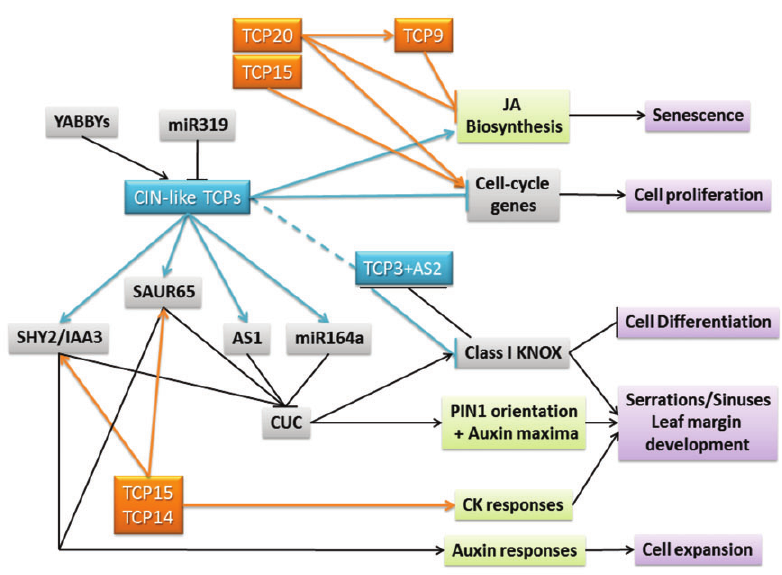
Figure 2 Molecular networks of CIN TCP protein action and their interaction with pathways modulated by class I TCPs (see text for